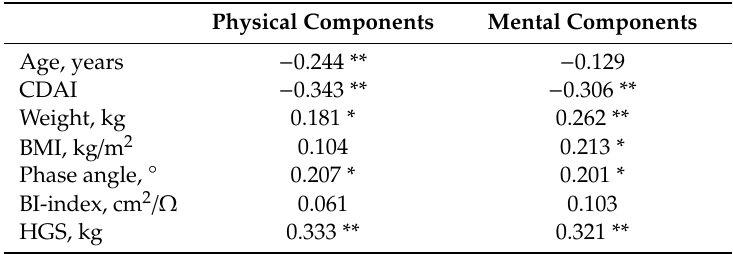
Table 4. Spearman’s correlation coe ffi cients between quality of life (QoL) and nutritional variables. Physical Components Mental Components Age, years − 0.244 **